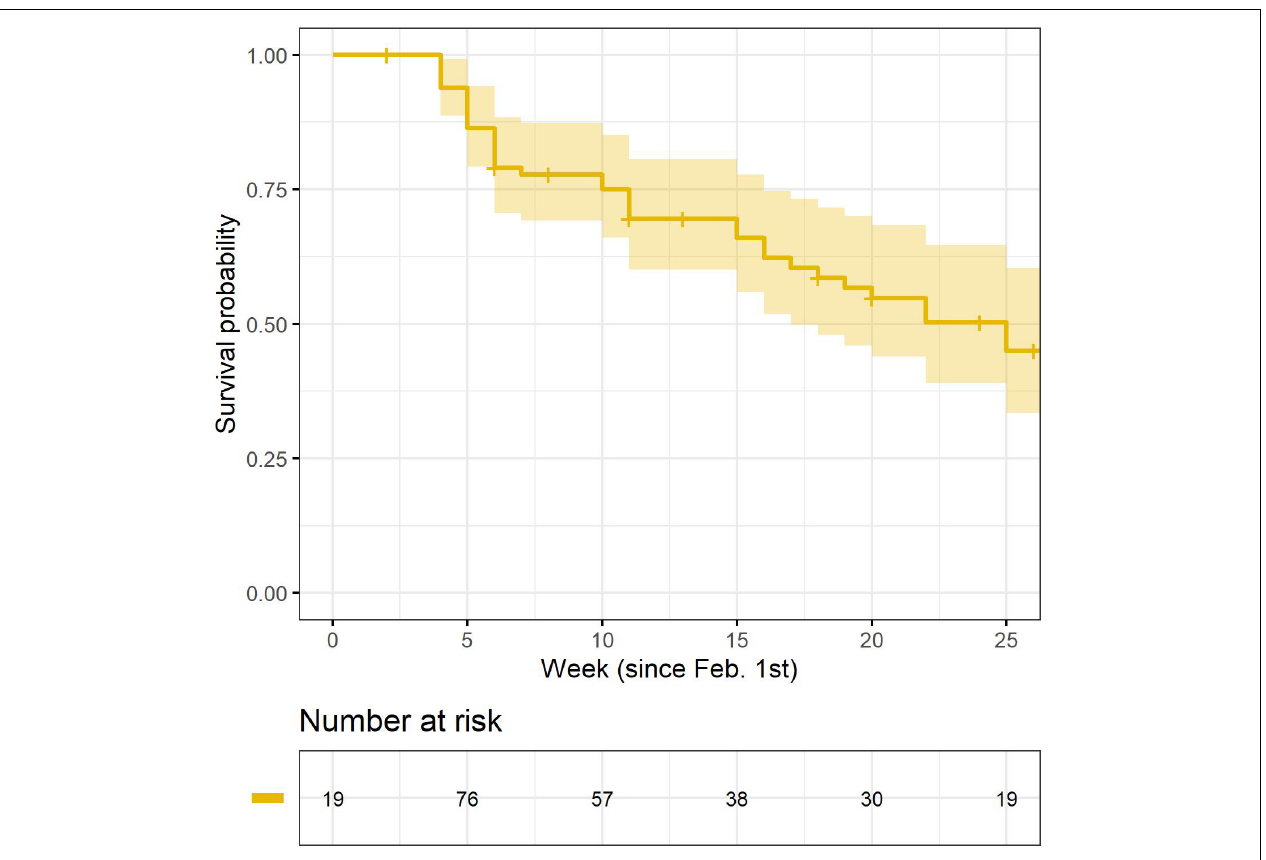
FIGURE 2 | Kaplan–Meyer survival curve for a sample of rock ptarmigan radio collared in Central Norway in 2012–2013. The time on the x -axis is shifted so that week 1 represent the 1st week in February each year, whereas week 26 is the last week in July. Lower table depicts the number at risk (i.e., time-specific sample sizes) throughout the study